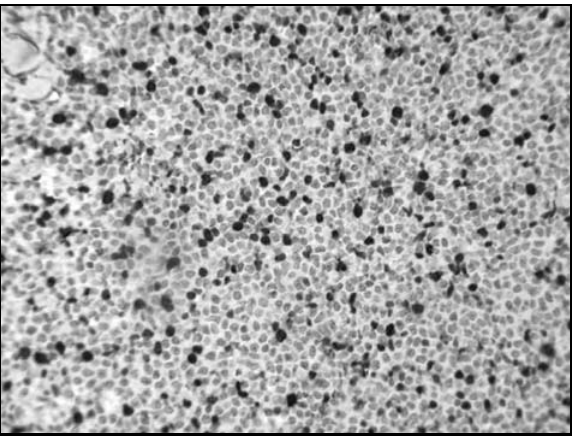
Figura 2 (caso 1) – Imunorreatividade nos núcleos de células neoplásicas para TdT